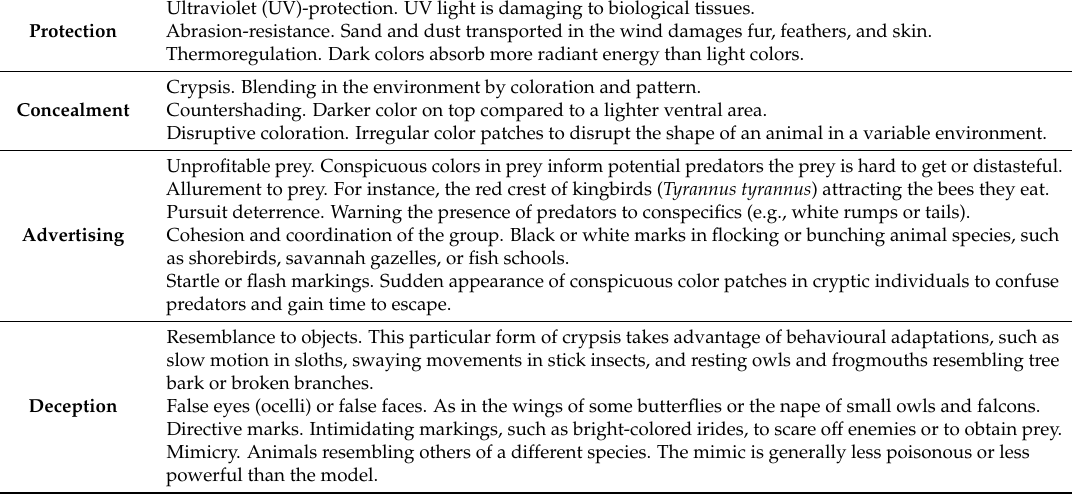
Table 1. Mechanisms of color evolution by natural selection, adapted from [19] for animals at large, and Bortolotti [18], who specifically referred to birds. Four broad categories are recognized, although several mechanisms may combine to explain general coloration and specific markings in multi-colored species. Conspicuous colorations mainly resulting from sexual selection or some specific types of intraspecific communication (e.g., marks for species recognition, for gender and/or age recognition, or parent–offspring visual signaling) are not